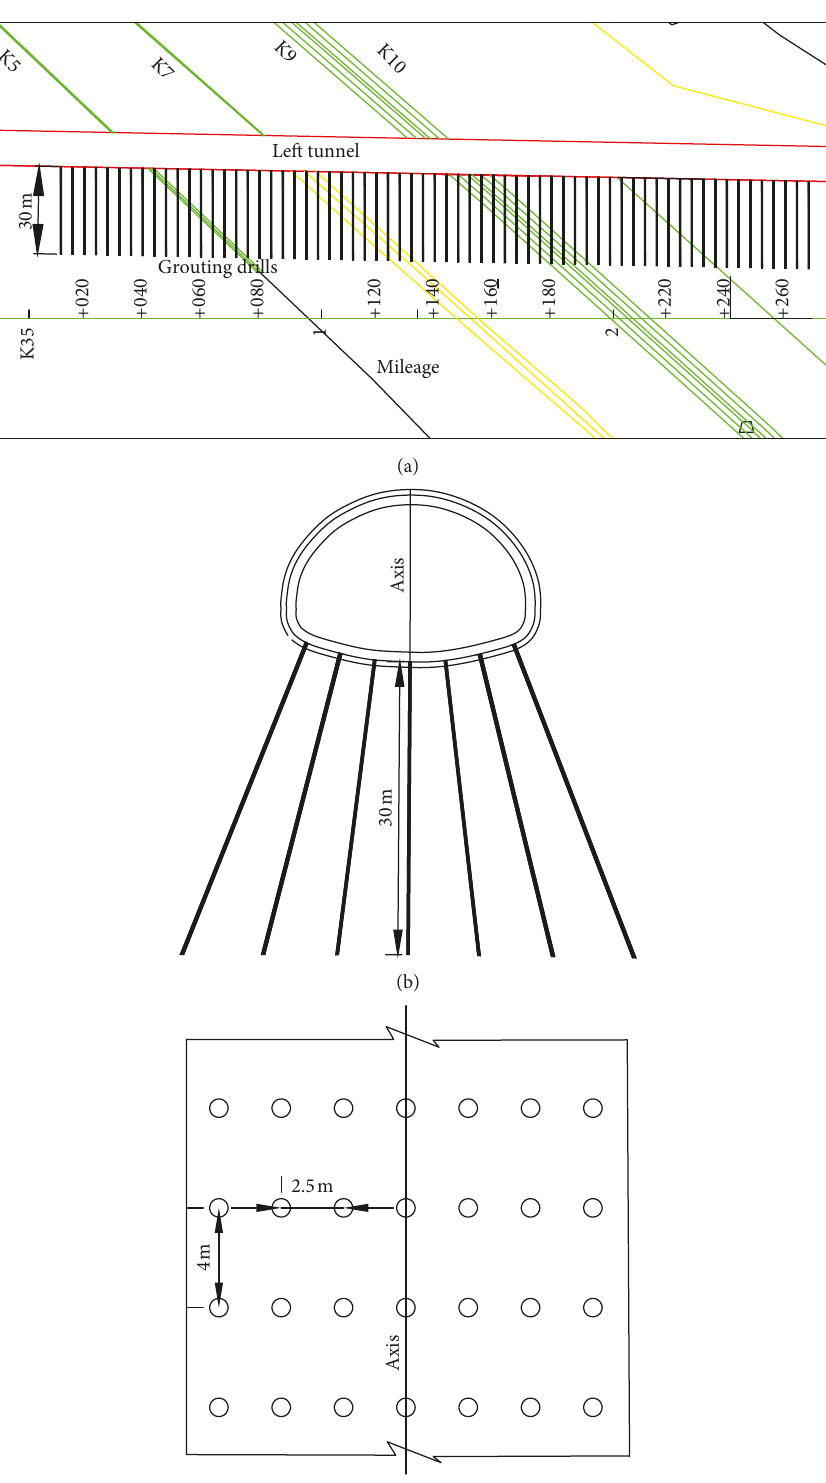
Figure 18: The grouting drill design drawing. (a) Vertical section. (b) Cross section. (c)